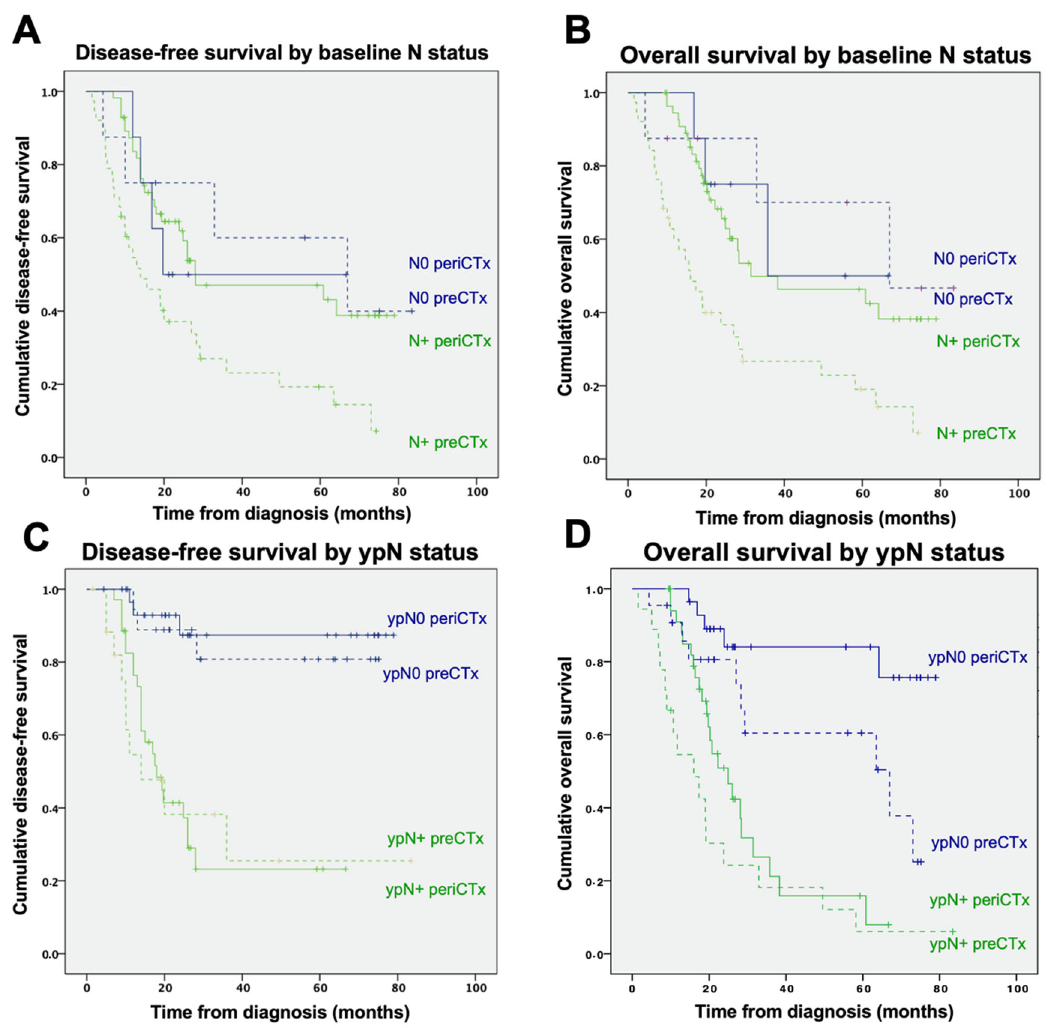
Figure 5. Disease ‐ free (DFS) and overall survival (OS) by nodal status at baseline (DFS ( A ); OS ( B )) and by at time of resection (DFS ( C ); OS ( D )). Negative nodal status is represented by blue lines. Green lines represent positive nodal status. Survival of patients receiving preoperative chemotherapy (preCTx) is marked by dashed lines.